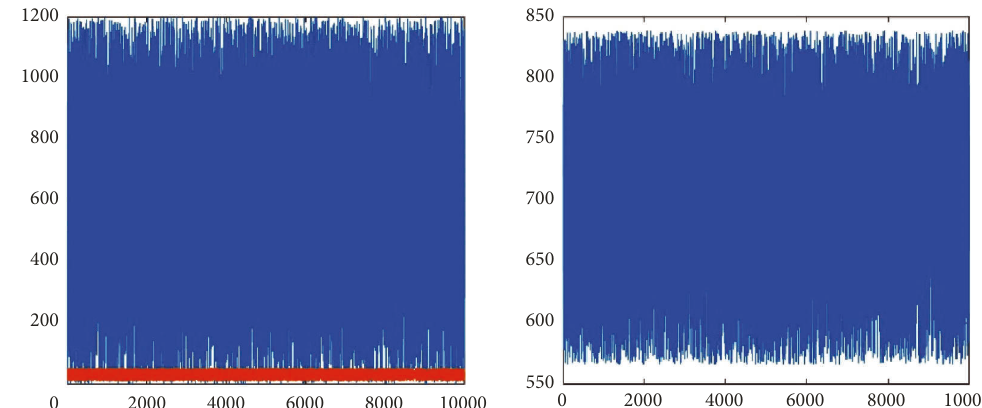
Figure 11: Possibility of radiation, temperature, and output